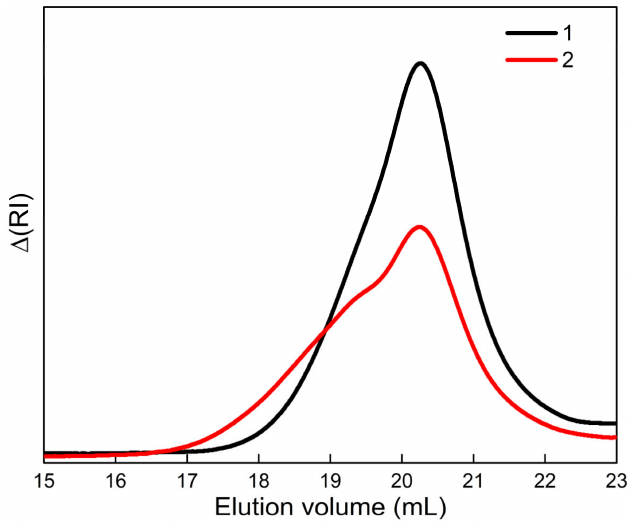
Figure 1. SEC traces of the precursor HCs (before hydrolysis) synthesized by